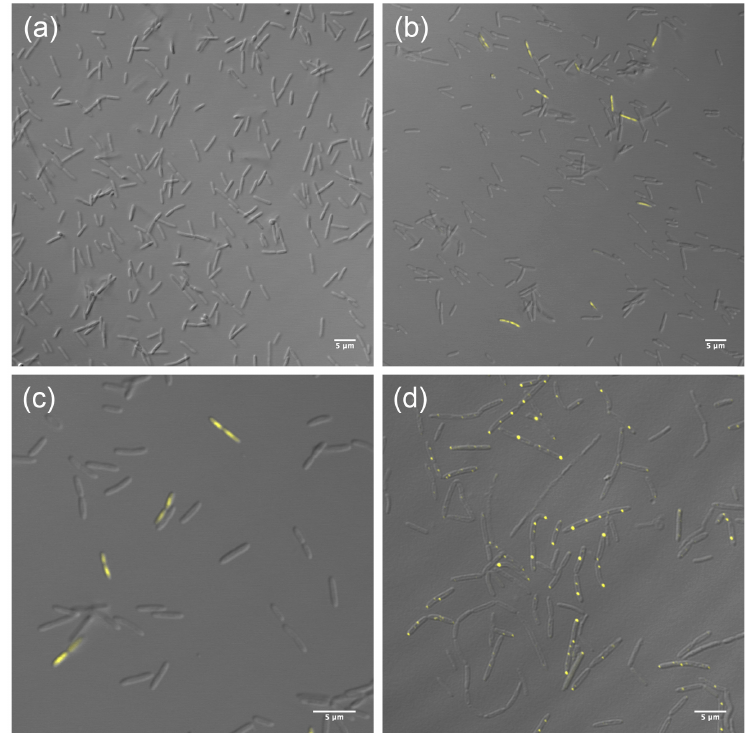
Figure 3. Localization of HepA. HepA-sYFP fusion expressed from a single copy in the chromosome under its natural promoter ( a – c ) or ectopically from a multicopy plasmid in a constitutive way ( d ). Panel ( a ) corresponds to untreated cells. Panels ( b ) and ( c ) correspond to different magnifications of UV-treated cells as described in the Materials and Methods Section.